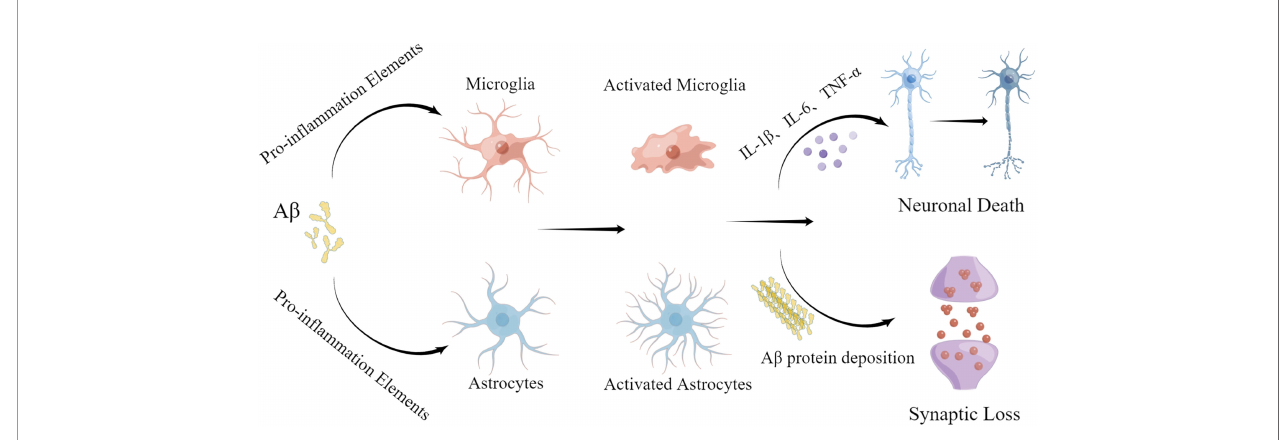
FIGURE 2 | Roles of microglia and astrocytes in AD. The neurotoxic effects of A b protein promote activation of microglia and astrocytes, leading to a neuroin fl ammatory response. Excessive activation promotes deposition of A b protein, leading to further nerve damage.